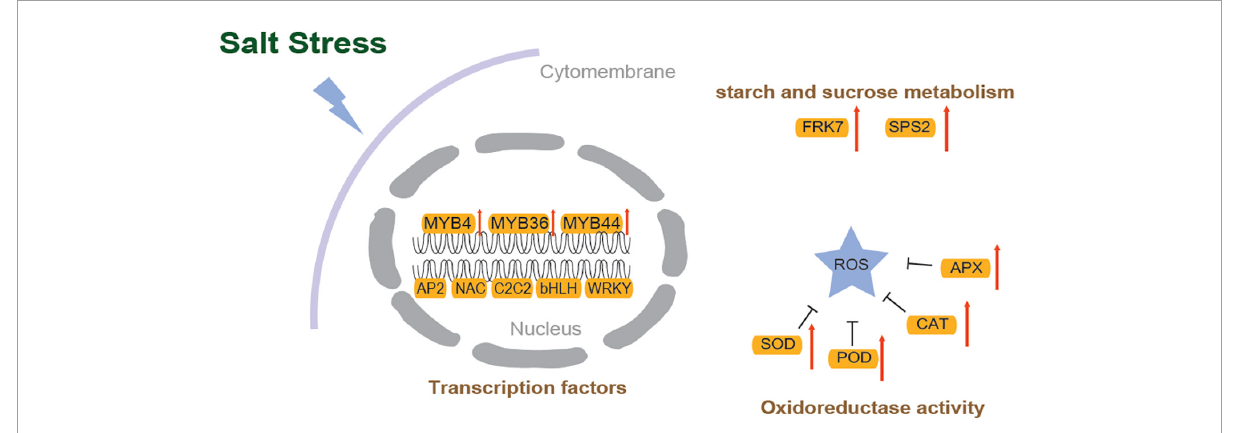
FIGURE8 The molecular mechanism for salinity tolerance of S. caseolaris